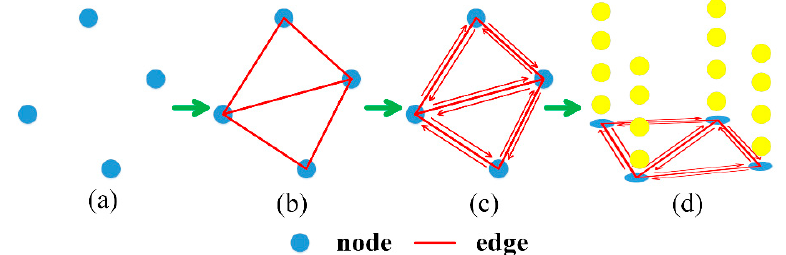
Figure 2. Feature point graph. Blue circles are feature points or nodes in the graph; red lines are edges in the graph; yellow circles are potential corresponding points. ( a ) is the set of feature points with blue circles being nodes in the graph; ( b ) is the Delaunay meshing results from these feature points with red lines being edges in the graph; ( c ) shows bidirectional edges between feature points; ( d ) shows the potential corresponding points (the yellow circles) of each feature point.